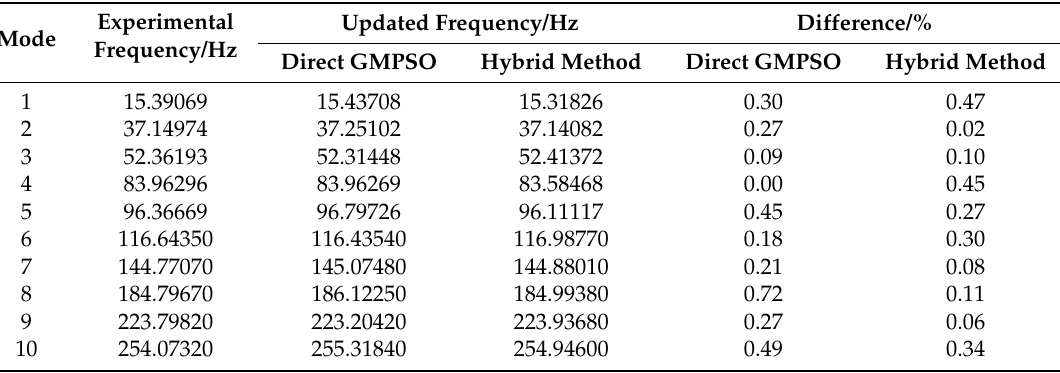
Table 2. The comparison between updated and experimental frequencies 1 .